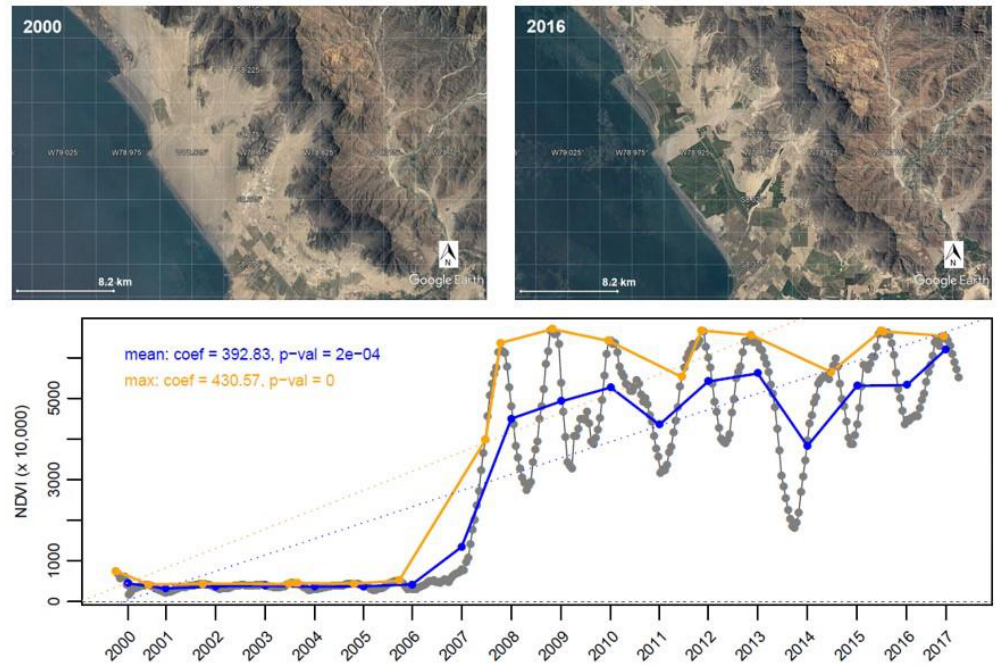
Figure 14. In the upper panels, high spatial resolution imagery from Google Earth Pro shows Dry Coast greening south of Trujillo between 2000 and 2016. Agricultural land use is expanding on the Dry Coast and converts desert to agriculture that produces greening signals in the data. The accompanying graph shows the entire time-series of the NDVI data and fitted Thiel-Sen trends for NDVI-mean (blue) and NDVI-maximum (orange) for a pixel located at S 8.312944 ◦ , W 78.914959 ◦